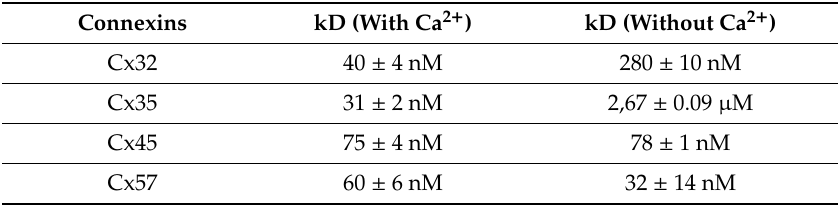
Table 1. CaM binding to